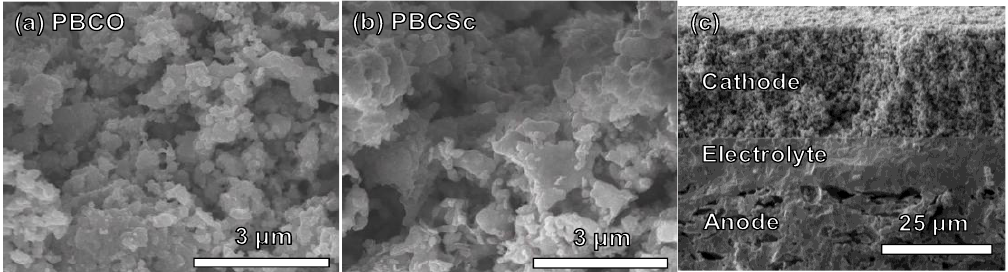
Figure 2. Scanning electron microscope image of ( a ) PBCO, ( b ) PBCSc and ( c ) a cross-section consisting of the GDC electrolyte with porous cathode and Ni–GDC anode.